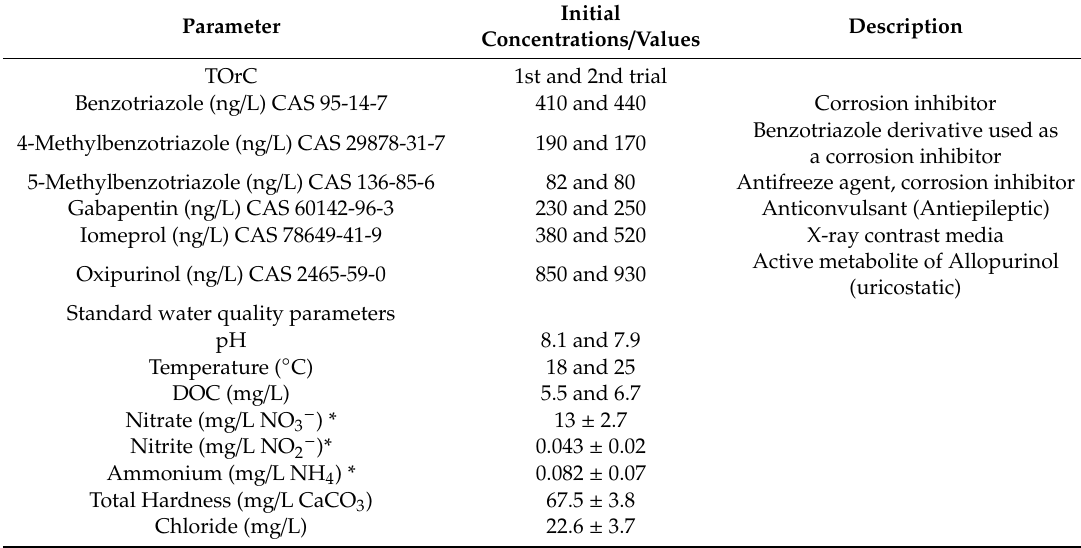
Table 2. Analyzed TOrCs concentrations of UF Filtrate and relevant water quality